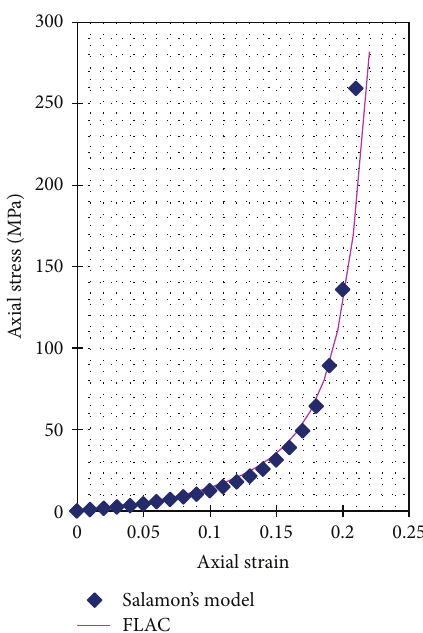
Figure 8: Stress-strain curve of the gob